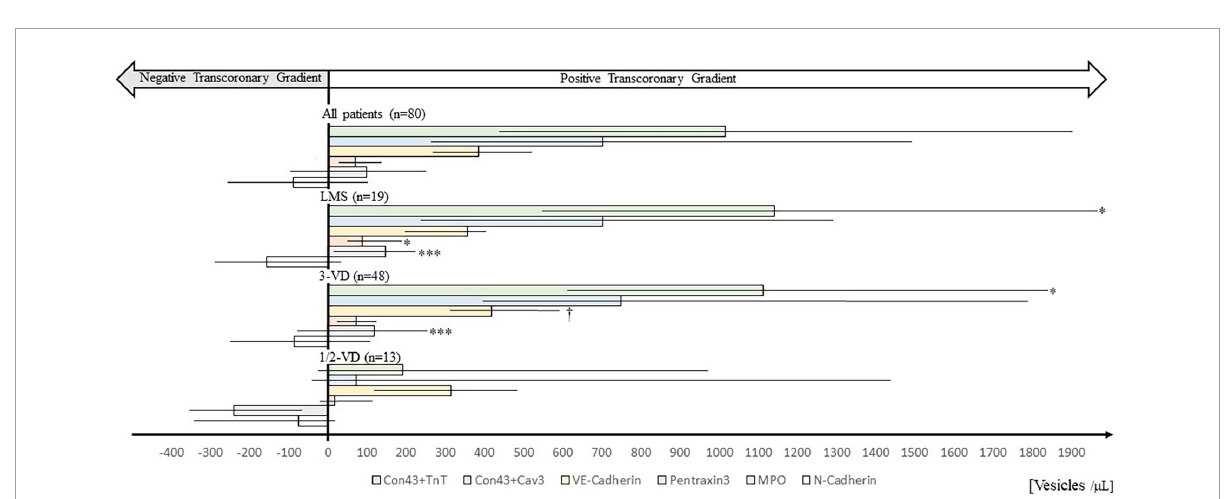
FIGURE2 Trans -coronary gradients of extracellular vesicles in patients presented by extent of coronary artery disease based on preoperative coronary angiography. Horizontal bars show median trans-coronary EV concentration gradients, calculated as plasma concentrations in coronary sinus minus plasma concentrations in radial artery. For comparison all patients (n 80) irrespective of disease severity are shown (top of figure). CAD angiography data was missing in one patient. Median values (bars), interquartile ranges (horizontal lines), and p-values (between patient group comparisons; Mann-Whitney U-test) are shown. ∗ p < 0.05, ∗∗∗ p < 0.001 compared to 1/2-VD. † p 0.05 compared to LMS. 1/2-VD, one or two-vessel disease; 3-VD, three-vessel disease; LMS, stenosis of the left main coronary artery. Con43 + TnT, Connexin-43 + Troponin T;